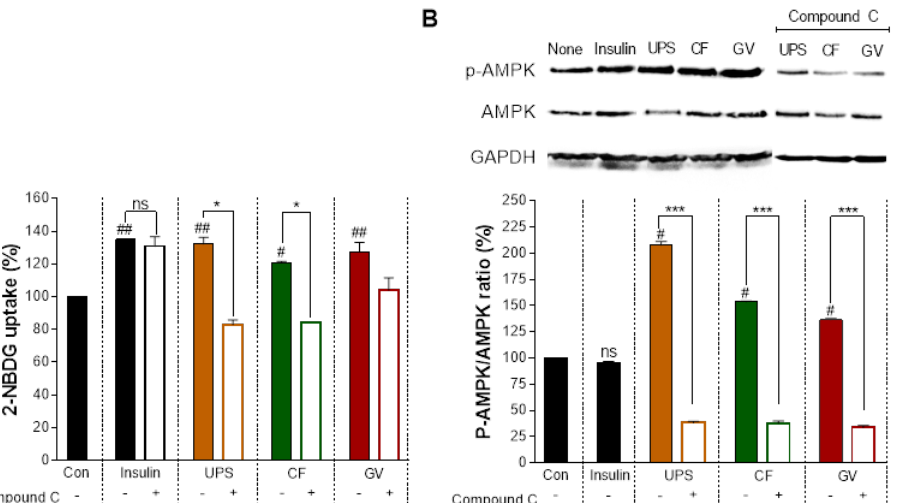
Figure 4. Effects of three seaweed extracts on glucose (2-NBDG) uptake and phosphorylation of AMPK with or without compound C in C2C12 myotubes. Myotubes were treated with 20 µ M of compound C and then exposed to 100 µ g/mL of the three seaweed extracts. ( A ) Alteration of 2-NBDG uptake rate by seaweed extracts with or without compound C, # p < 0.05, ## p < 0.01; compared with control using one-way ANOVA with Dunnett’s comparison test, * p < 0.05; compared values with and without compound C using t -test, ( B ) alteration of AMPK phosphorylation by UPS, CF, and GV treatment with or without compound C in C2C12 myotubes. # p < 0.0001; compared with control using one-way ANOVA with Dunnett’s comparison test, * p < 0.05, *** p < 0.0001 compared values with and without compound C using t -test. Data are represented as the mean ± SEM. Abbreviations: UPS; Undaria pinnatifida sporophyll, CF; Codium fragile , GV; Gracilaria verrucose , Control;